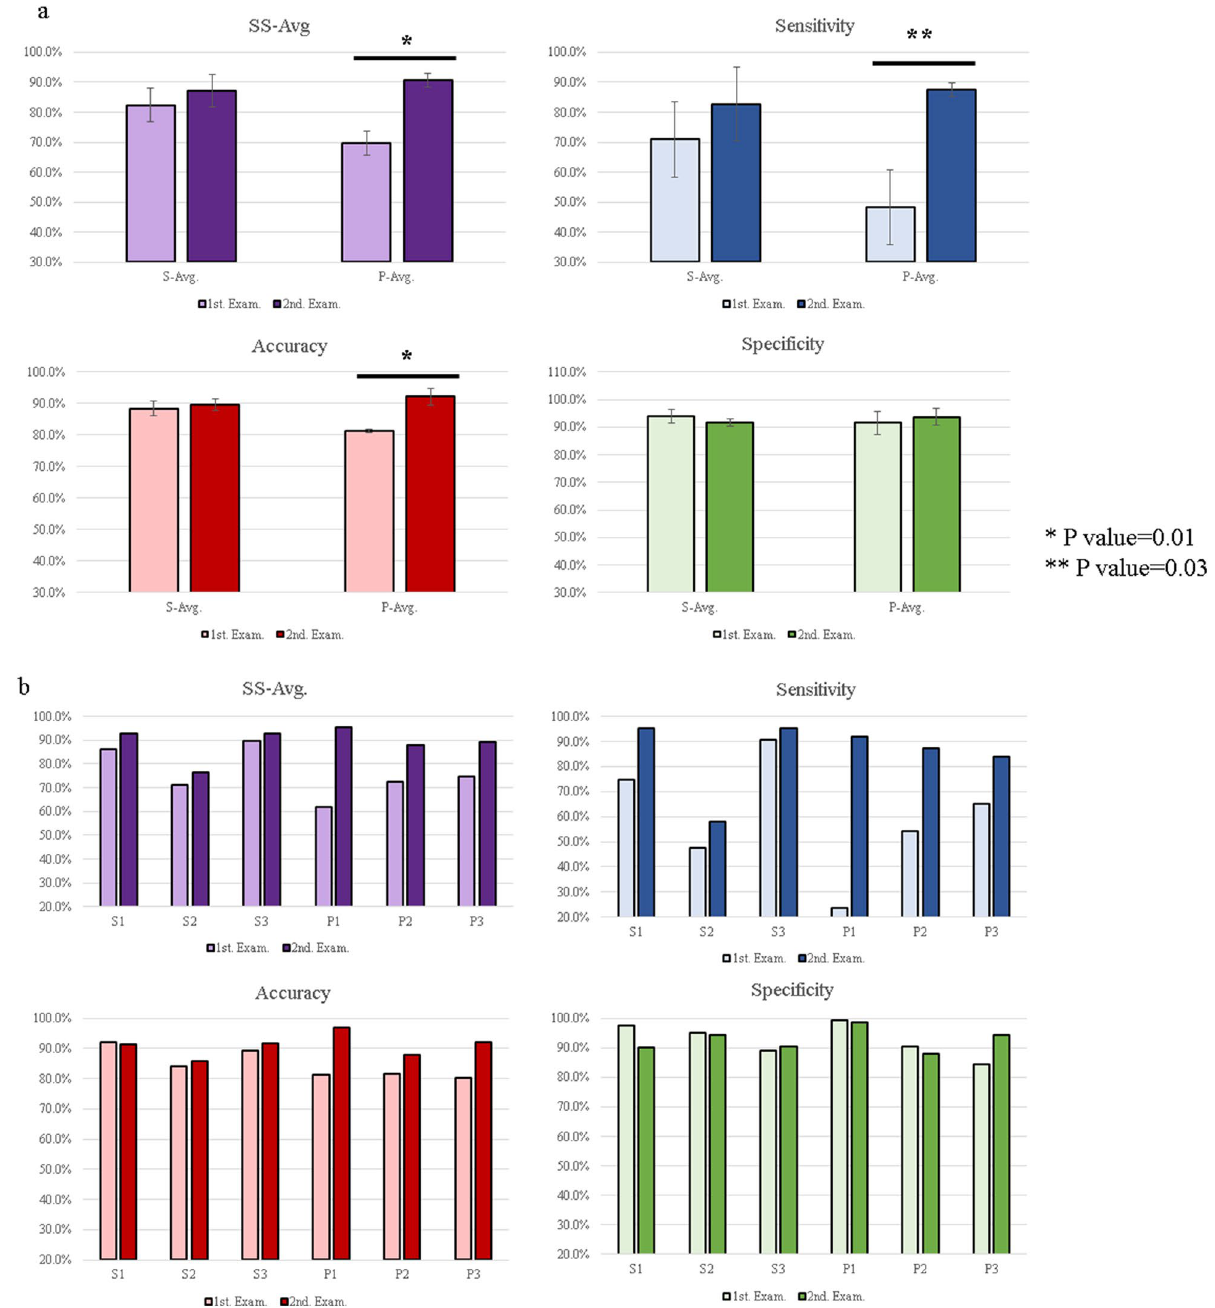
Figure 2. Comparison of diagnostic examinations. ( a ) Comparison between the first (no AI support) and second (AI-supported) diagnostic examinations for the data averages. For the radiological practitioners, all parameters show an increase between the first and second diagnostic examinations. The SS-Avg, accuracy, and sensitivity show significant increases ( p < 0.05). Error bars indicate means ± SD. * p < 0.01, two-sided; ** p < 0.05, two-sided. ( b ) Comparison between first (no AI support) and second (AI-supported) diagnostic examinations for the individual data. A comparison of the radiologist results between the first and the second diagnostic examinations show an increase in the SS-Avg and sensitivity for all radiologists. ( c / d ). ROC curves of individual results with of the DNN models. The figures show ROC curves of the individual results of the first (no AI support, c ) and the second (AI-supported, d ) diagnostic examinations. The ROC curves are based on the results of Combination Set 1 (shown in Table 1). The AI support improved the individual results. ( e / f )Correlation diagrams of misdiagnosed images are shown for the uterine-sarcoma groups ( e ) and the uterine leiomyomas ( f ). The cases misdiagnosed by either the DNN models (blue circles), radiologists (red circles), or both (purple circles) are shown. The histopathological types of the false negatives from the DNN models included 1 case of STUMP, 2 cases of cervical adenosarcoma, and 3 cases of